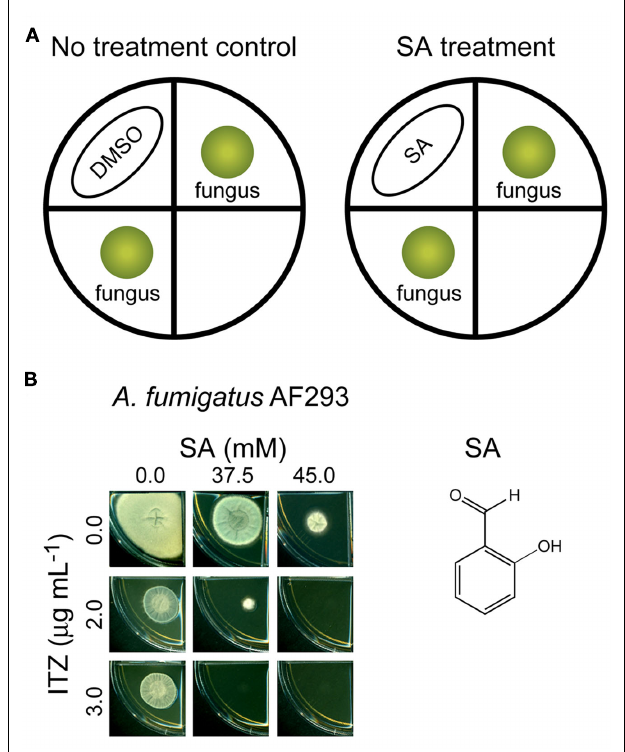
FIGURE 4 | Phenotypic responses of yeast pathogens to itraconazole (ITZ) and tert -butyl hydroperoxide ( t -BuOOH). Results showed that Candida krusei 6258 and Cryptococcus neoformans CN24, two ITZ-sensitive strains, were also sensitive to t -BuOOH, indicating the correlation between ITZ toxicity and oxidative stress. Results shown here are representative data from the treatment with 1.0 μ gmL − 1 of ITZ and 1.5mM of t -BuOOH,